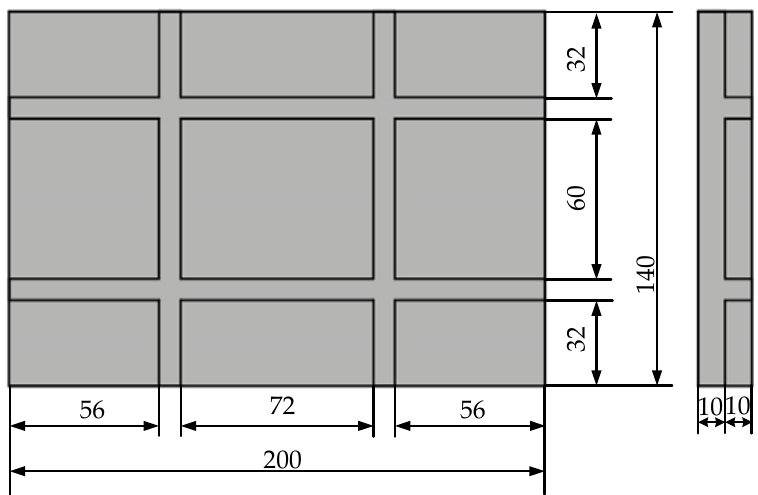
Figure 7. Geometric dimensions (mm) of 2D SiC/SiC stiffened plate. Table 4. Material parameters of 2D SiC/SiC stiffened plate.